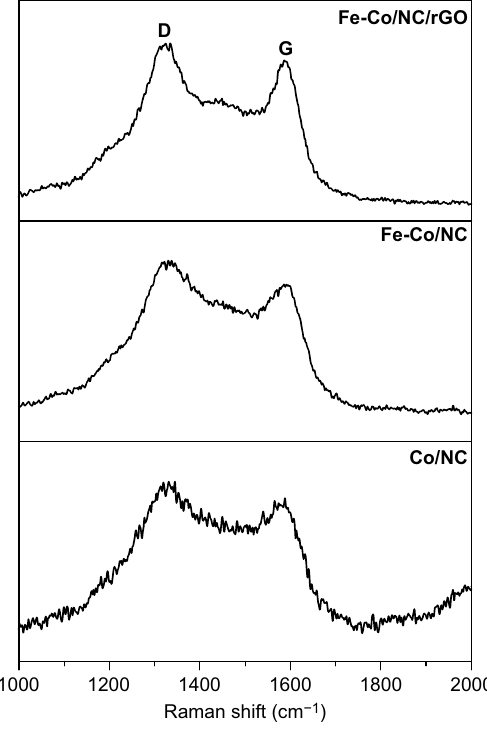
Fig. 4 Raman spectra of Co/NC, Fe–Co/NC, and